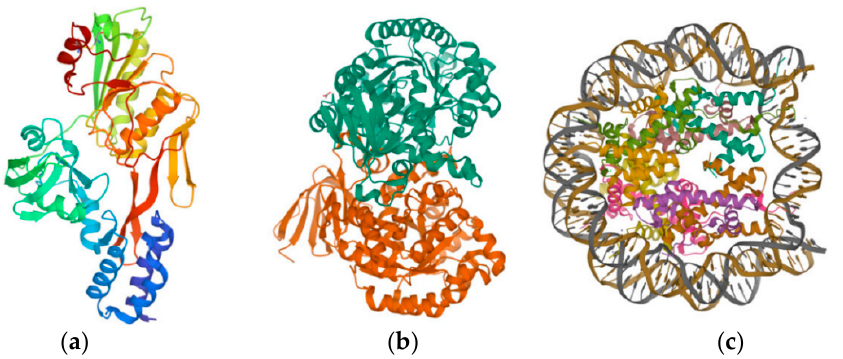
Figure 4. Schematic structure of the herbicidal, degradative, and toxic receptor proteins of S-THs: ( a ) 1FC9; ( b ) 4L9X; ( c ) 6K1J.